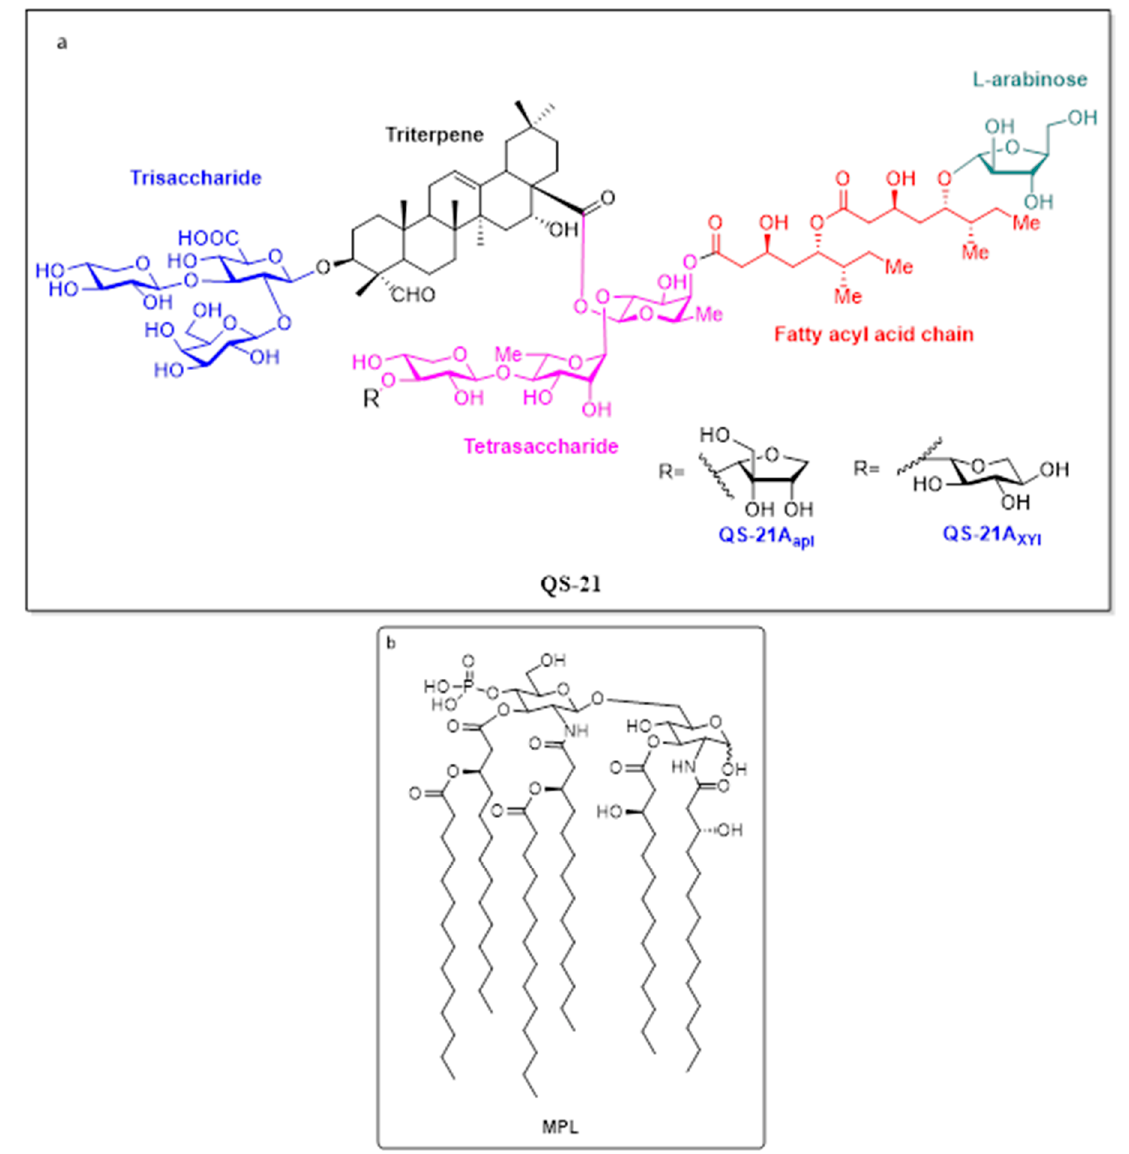
Figure 3. Structures of QS-21 ( a ) and MPL ( b ).